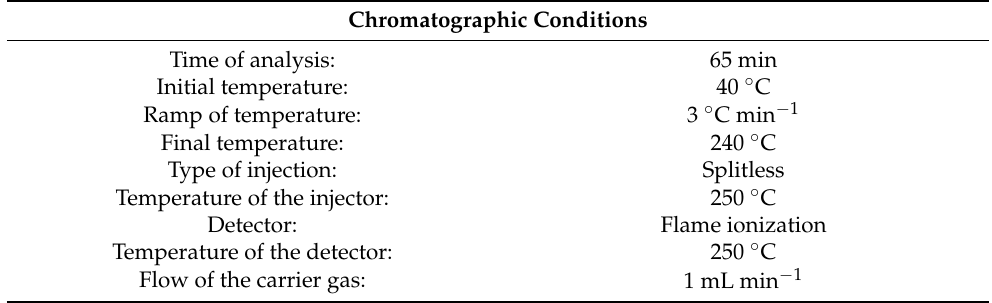
Table 1. Chromatographic conditions used for the analysis of volatiles compounds in Habanero pepper.